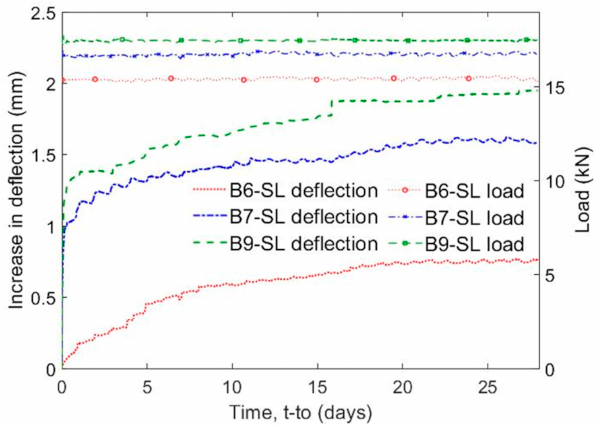
Figure 14. Sustained load and deflection with the time for the first stage (series II).